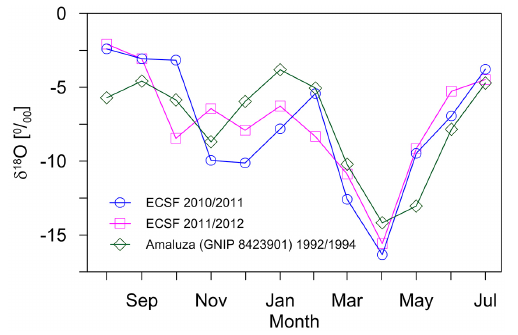
Fig. 4. Monthly isotopic δ 18 O signals between two consecu- tive years (2010–2012) at ECSF (1900ma.s.l.) and averaged monthly values (1992–1994) at Amaluza GNIP station (lat − 2.61, long − 78.57; altitude